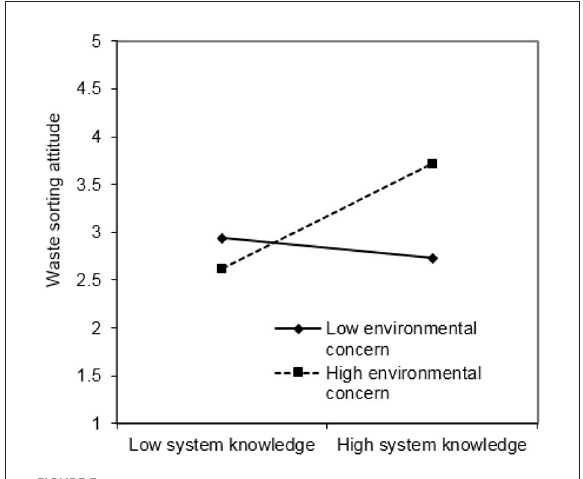
FIGURE3 Moderation plot of system